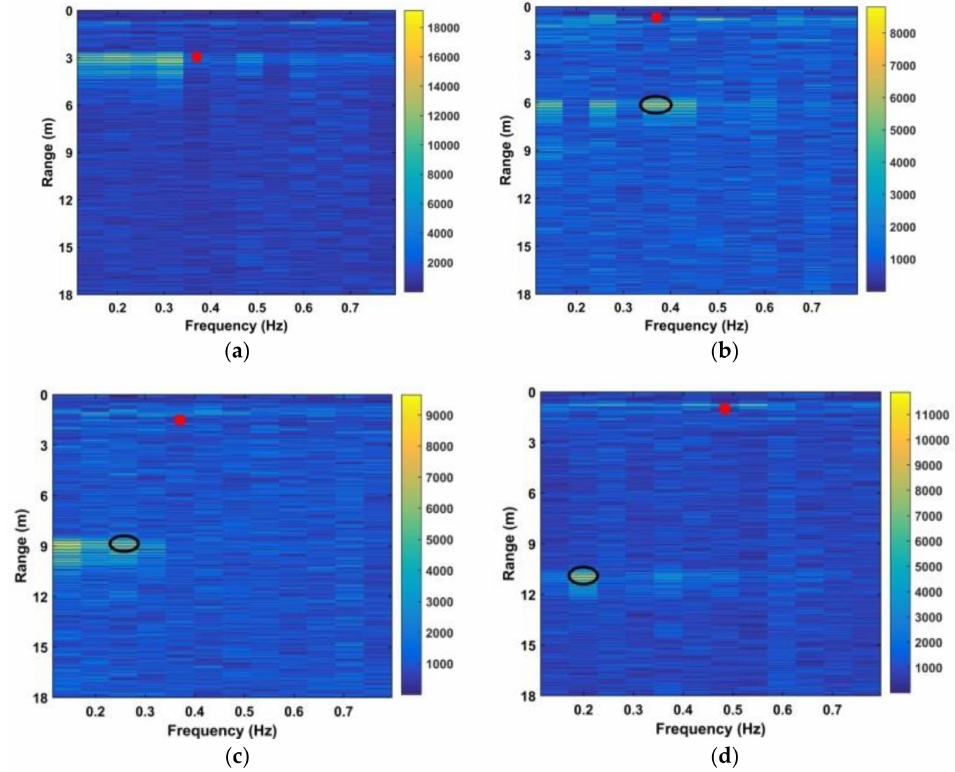
Figure 15. Results using the CFAR method with a human subject at distances between the antenna and human subject of ( a ) 300 cm, ( b ) 600 cm, ( c ) 900 cm, and ( d ) 1100